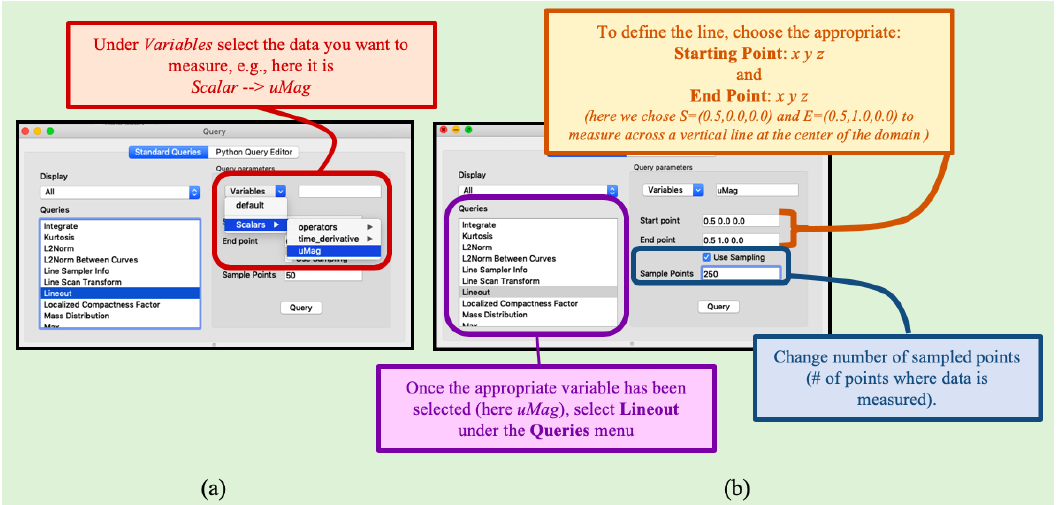
Figure 17. Within the Query dialog box, select ( a ) the chosen data to measure, e.g., here it is uMag , and ( b ) the Lineout option to measure the data across a line within the domain that is defined by a starting and ending